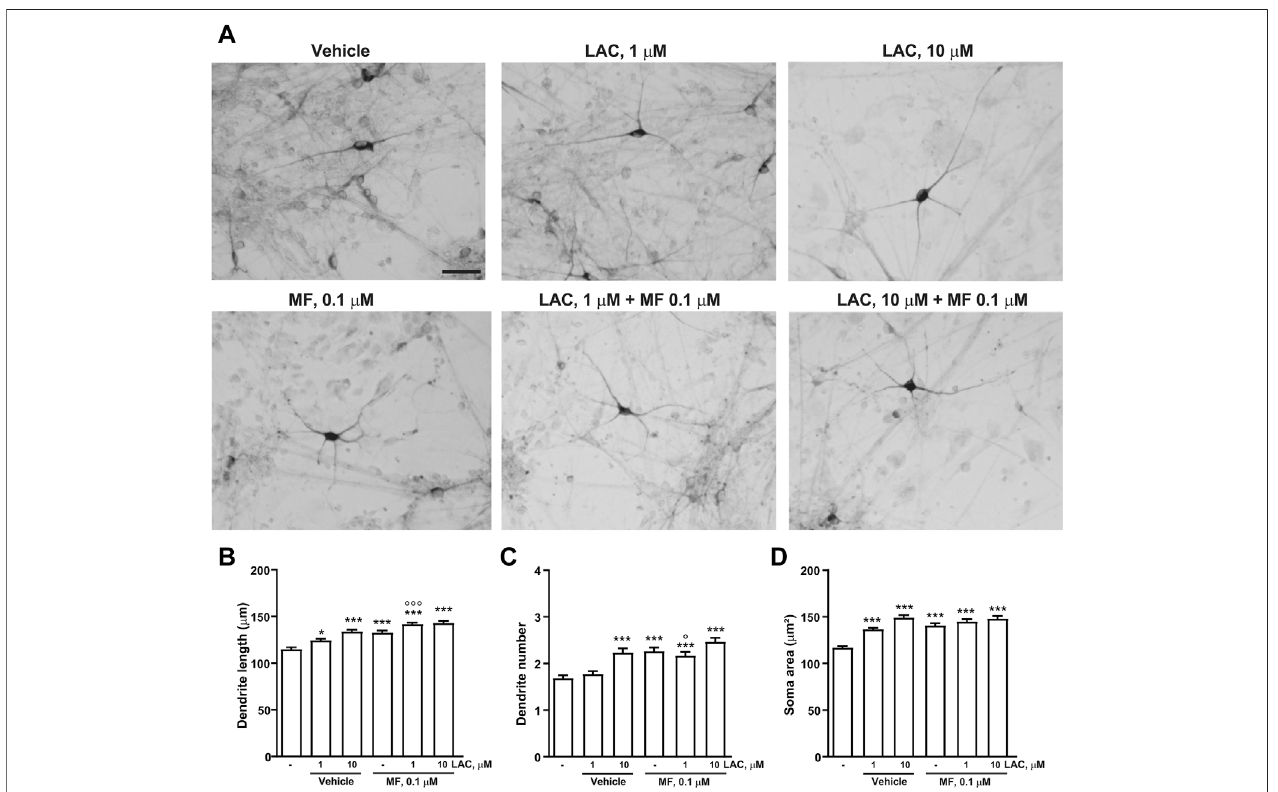
FIGURE7| CombinationtreatmentwithLACandMFonhumaniPSC-derivedDAneurons.RepresentativephotomicrographsofhumanF3DAneurons(40 daysin culture)72 hafterexposuretovehicle,LAC(1,10,50 μ m),MF(0.1,1,5 μ m)andthecombinationofLACandMFareshownin (A) .Scalebar:50 μ m.Treatmenteffecton maximaldendritelength,numberofprimarydendritesandsomaareaofhumanF3DAneuronsisshownin (B – D) .Inallpanels,valuesarerepresentedasmean±S.E.M. (*** p < 0.001;** p < 0.01;* p < 0.05vs. vehicle; +++ p < 0.001; p < 0.05 vs.LAC 1 μ m; One-way ANOVA +Fisher ’ sLSD) (B) F (5,594) =21.75; p < 0.0001 (C) F (5,594) = 13.67; p < 0.0001 (D) F (5,592) = 22.31; p <